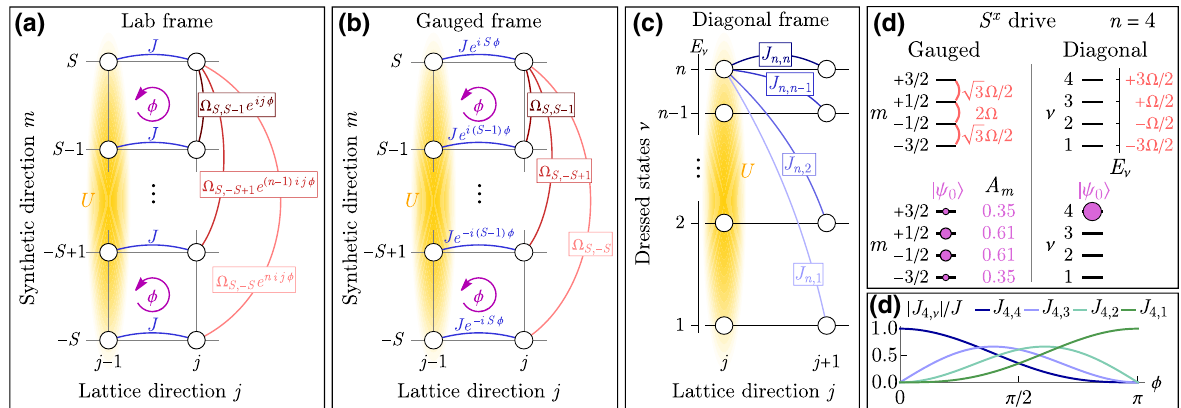
FIG. 5. (a) Schematic of the n > 2 system now engineering an n -leg ladder in the lab frame. The synthetic dimension states are indexed m ∈ {− S , − S + 1, . . . , S } with S = ( n − 1 )/ 2 the size of an effective onsite spin. Motion along the synthetic direction is (cid:10) )φ to emulate the magnetic field. Only the induced by a laser with couplings (cid:2) m , m (cid:10) between internal states m , m (cid:10) and a phase e ij ( m − m couplings from the m = S state to the others are shown for simplicity, although generically each spin state can be coupled to each other. The SU ( n ) symmetric interactions are all to all in the synthetic dimension and onsite in the lattice dimension. (b) Visualization of the same system in the gauged frame where the flux is put into the tunneling terms. (c) Visualization of the system in the diagonal frame, where the synthetic spin dimension is comprised of dressed spin states ν ∈ { 1, . . . , n } that are single-particle eigenstates of the drive. In this frame the nearest-neighbor tunneling can flip spin from ν to ν (cid:10) with corresponding matrix element J ν , ν (cid:10) . Again, only couplings from ν = n are shown for simplicity, although all dressed states generically couple to all others. (d) Couplings between spin states in ˆ the gauged frame and corresponding dressed energy levels in the diagonal frame for a S x -type drive and n = 4 states. The typical initial state of all atoms in the highest-energy dressed state ν = 4 is shown in both frames with the corresponding wavefunction amplitude A m of each spin state in the gauged frame. (e) Tunneling matrix elements J ν , ν (cid:10) allowed for the initially occupied dressed state ν = 4 for the drive in panel